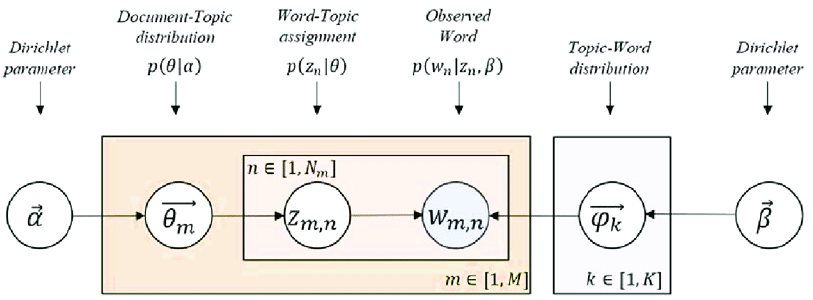
Figure 1. Latent Allocation Dirichlet (LDA) for